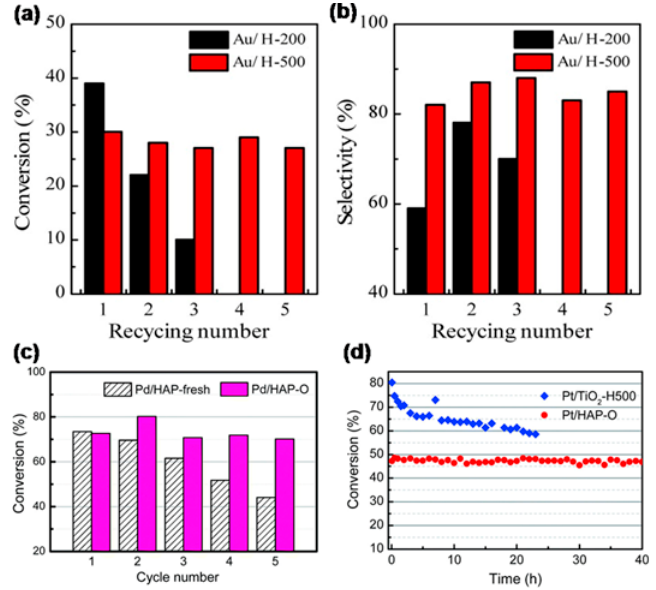
Figure 7. ( a ) Conversion and ( b ) selectivity of benzyl alcohol over Au/H-200 and Au/H-500. Reproduced with permission from [45], copyright: 2016 by the American Chemical Society. ( c ) Cycling performance of Pd/HAP-fresh and Pd/HAP-O for the Suzuki cross-coupling reaction. ( d ) CO conversion versus reaction time of Pt/HAP-O and Pt/TiO 2 -H500 samples at 400 °C. Space velocity of Pt/HAP-O and Pt/TiO 2 -H500 were ~1690,000 and 1100,000 L g Pt − 1 h − 1 , respectively. Reproduced with permission from [46], copyright: 2018 by The Royal Society of Chemistry.